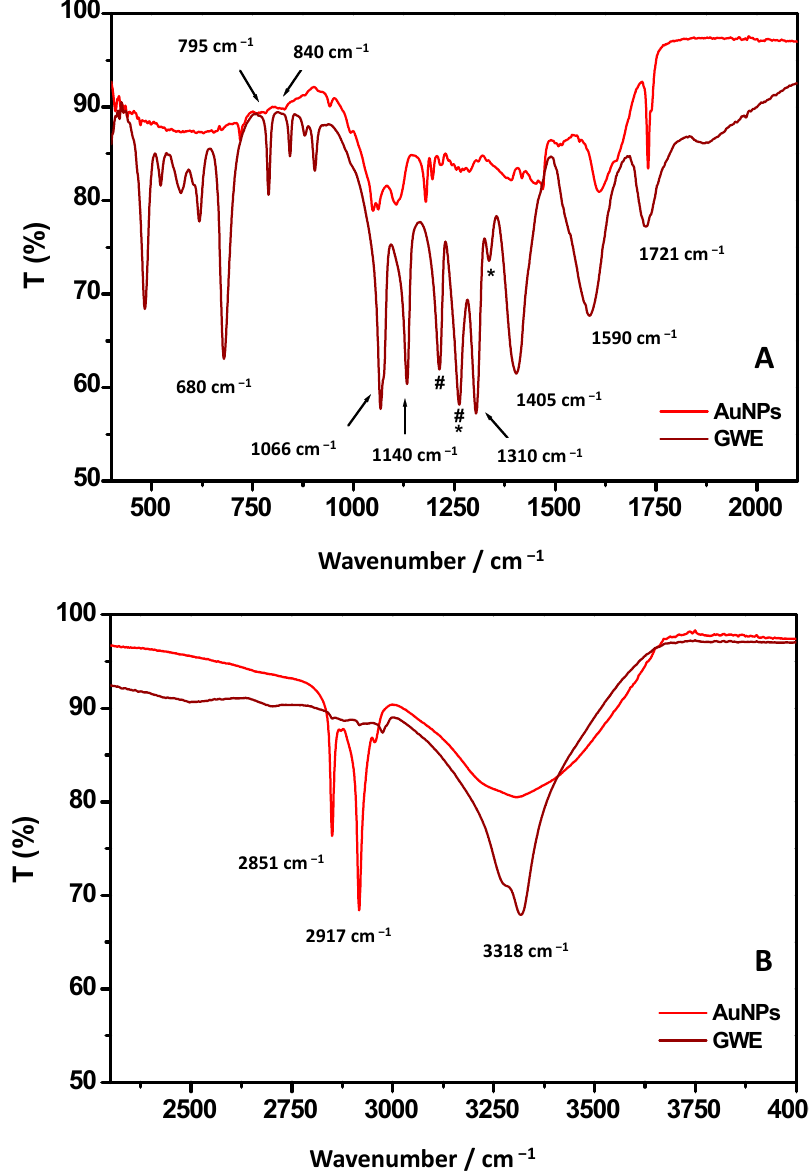
Figure 3. ATR-FTIR spectra of AuNPs and raw GWE referred to 500–2000 cm − 1 ( A ) and 2500–4000 cm − 1 ( B ) wavenumber regions. The signals at 1200 and 1252 cm − 1 (indicated with * and #) are due to vibrations of C–O and C-OH groups, respectively, attributed to hydroxyflavonoids.